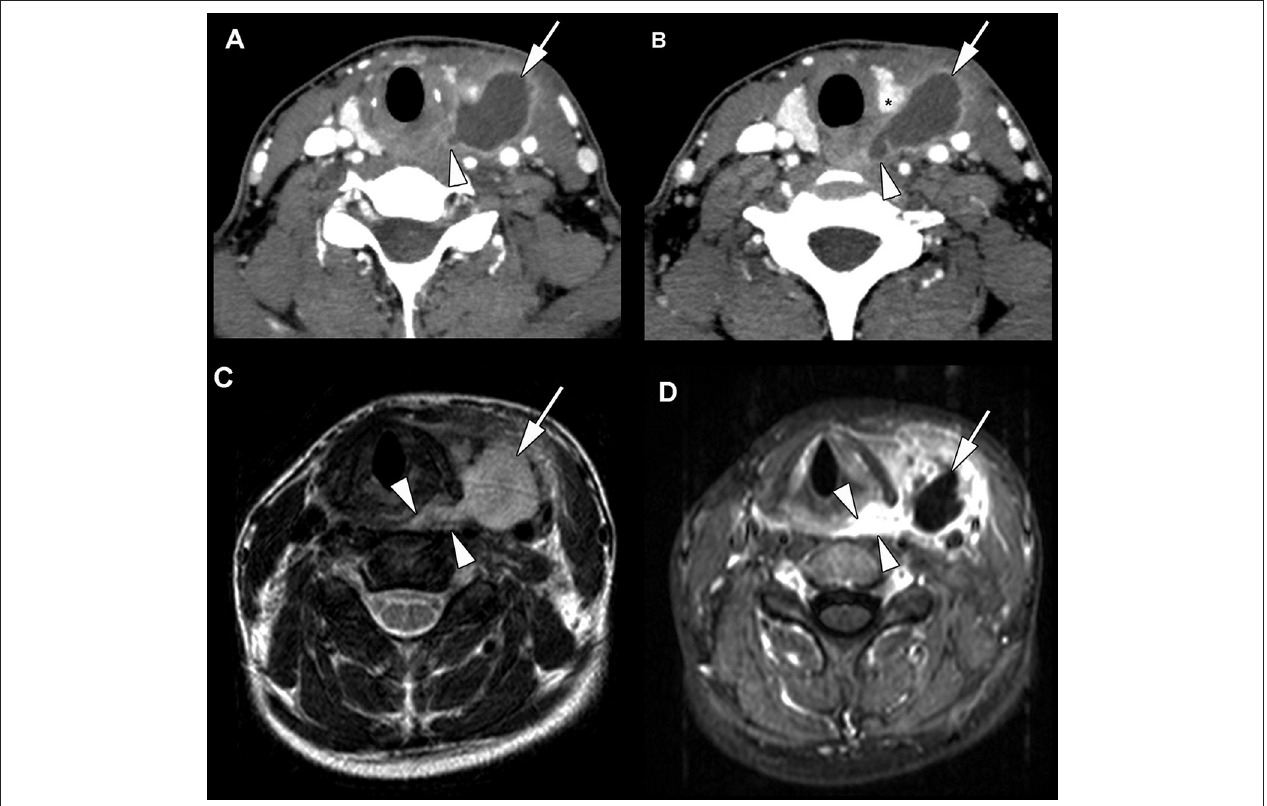
FIGURE 2 | Nineteen year old patient, presenting in the emergency department with fever, throat pain, and left side neck swelling. The patient experienced three similar episodes during the last 3 years. (A,B) Contrast-enhanced CT study, obtained at admission to the emergency department. Hypodense mass lesion with rim enhancement (arrow) between the left thyroid lobe (X) and neck vessels, extending to the region of the left pyriform sinus apex and esophageal verge (arrowhead). These findings are compatible with an abscess secondary to a fourth branchial arch fistula. After abscess drainage and intravenous antibiotics, direct laryngoscopy confirmed the presence of a fistula originating from the left pyriform sinus. After endoscopic resection of the fistula, the patient remained symptom free. (C,D) MRI study, performed in another hospital, 3 years earlier. T2-weighted (C) and gadolinium-enhanced T1-weighted (D) image show similar findings as in images (A,B) collection (arrow) with surrounding inflammation, connecting to the pyriform sinus (arrowheads). This was recognized as a neck abscess, but the diagnosis of a fourth branchial arch anomaly was not made. Treatment at that time was abscess drainage and intravenous antibiotics.